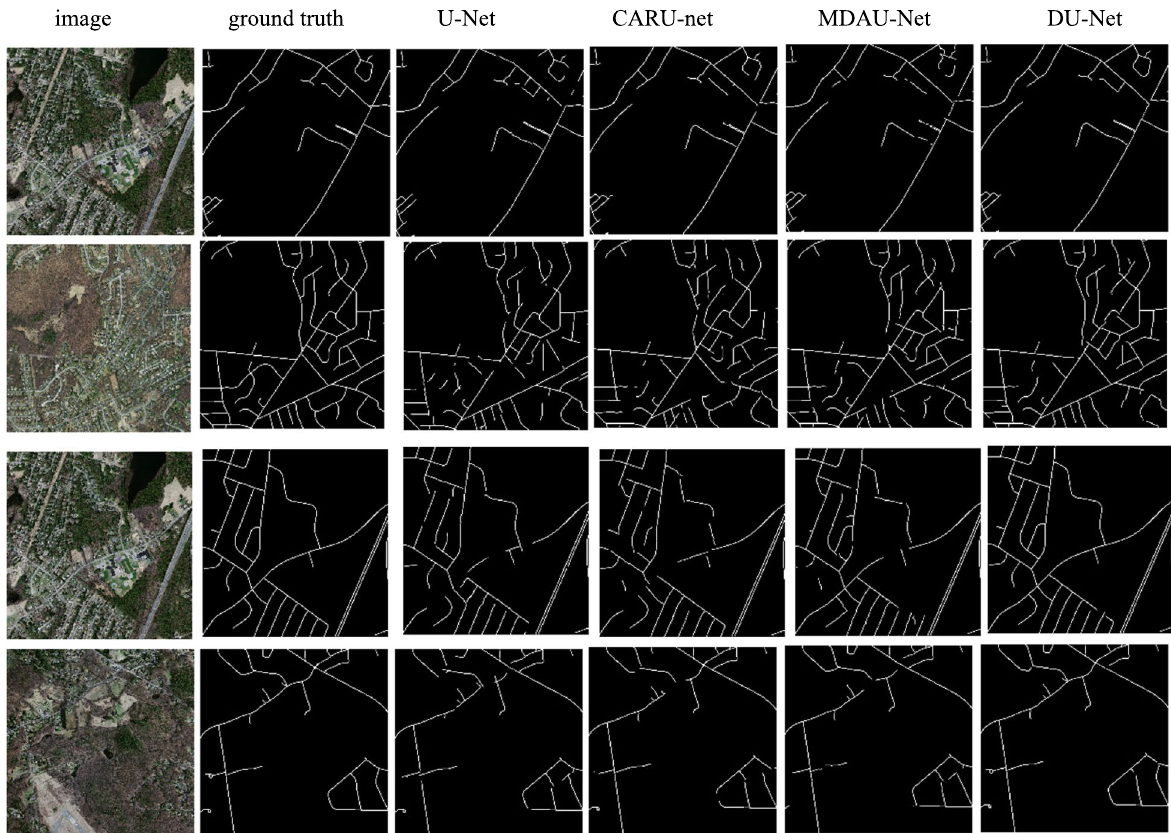
Fig. 10 Road comparison experiment extraction results